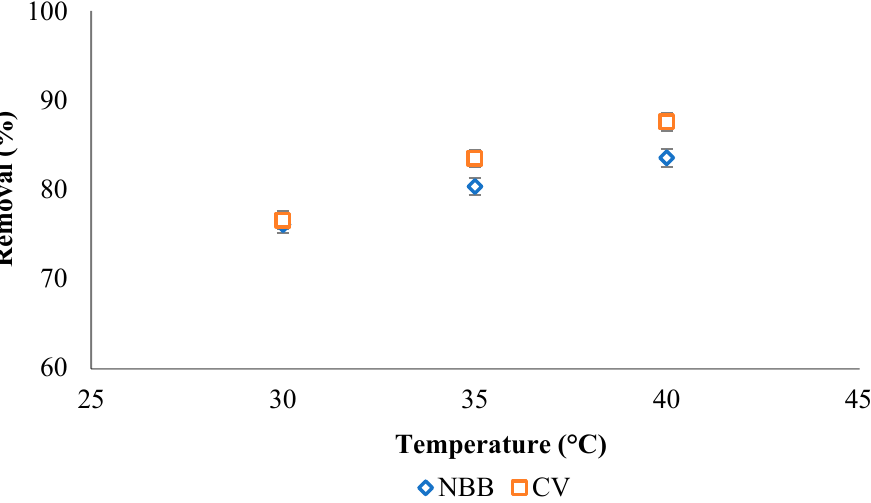
Figure 10. Effect of temperature on the efficiency of removal of 100 mg L − 1 NBB and CV dyes onto ACOC.